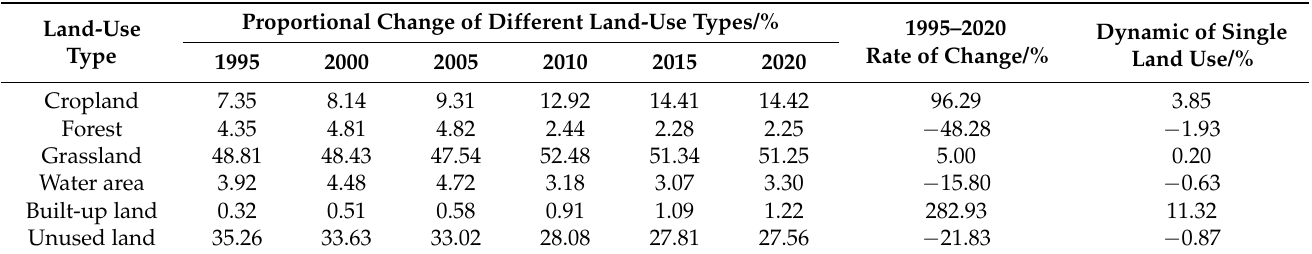
Table 3. Land-use area percentage and dynamic degree in the Ebinur Lake Basin from 1995 to